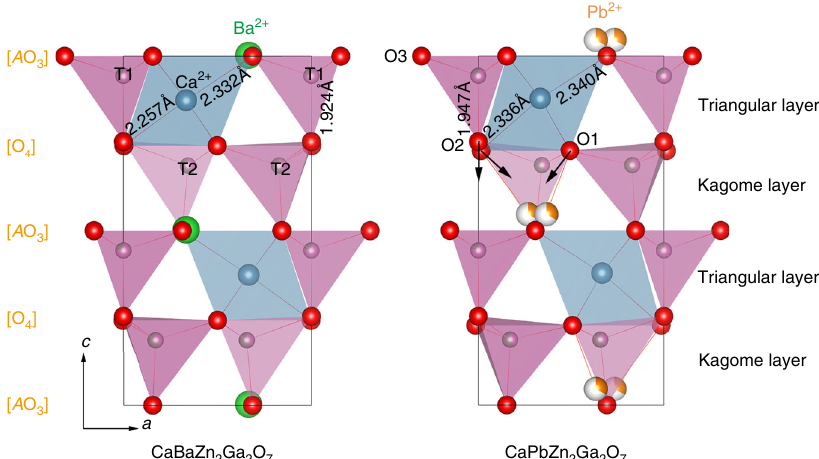
Fig. 4 Crystal structures for CaBaZn 2 Ga2O 7 and CaPbZn 2 Ga 2 O 7 . Crystal structures were obtained from the combined Rietveld re fi nements on ND and XRD data with the P 6 3 mc model. In both structures T1 and T2 sites are co-occupied by Ga 3 + and Zn 2 + but with different occupancies, where T1 site is dominated by Ga 3 + with an occupancy factor of 0.79(3), accordingly T2 site is mainly occupied by Zn 2 + with an occupancy factor of 0.60(2). The black arrows represent the shift direction of oxygen atoms.